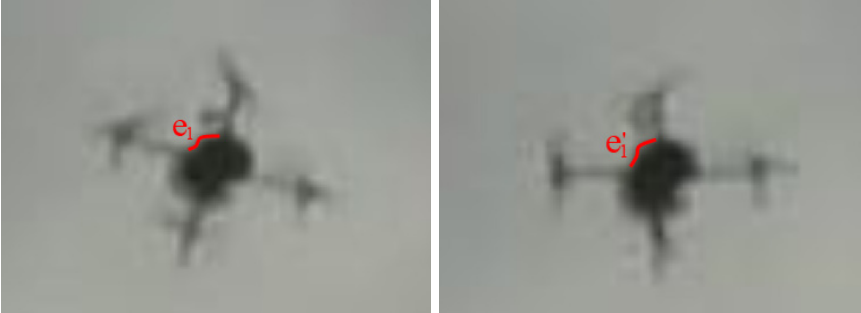
e and ′ e are aligned edges from neighboring frames ). Figure 5. Illustration of edge alignment ( e 1 and e (cid:48) 1 are aligned edges from neighboring 1 1